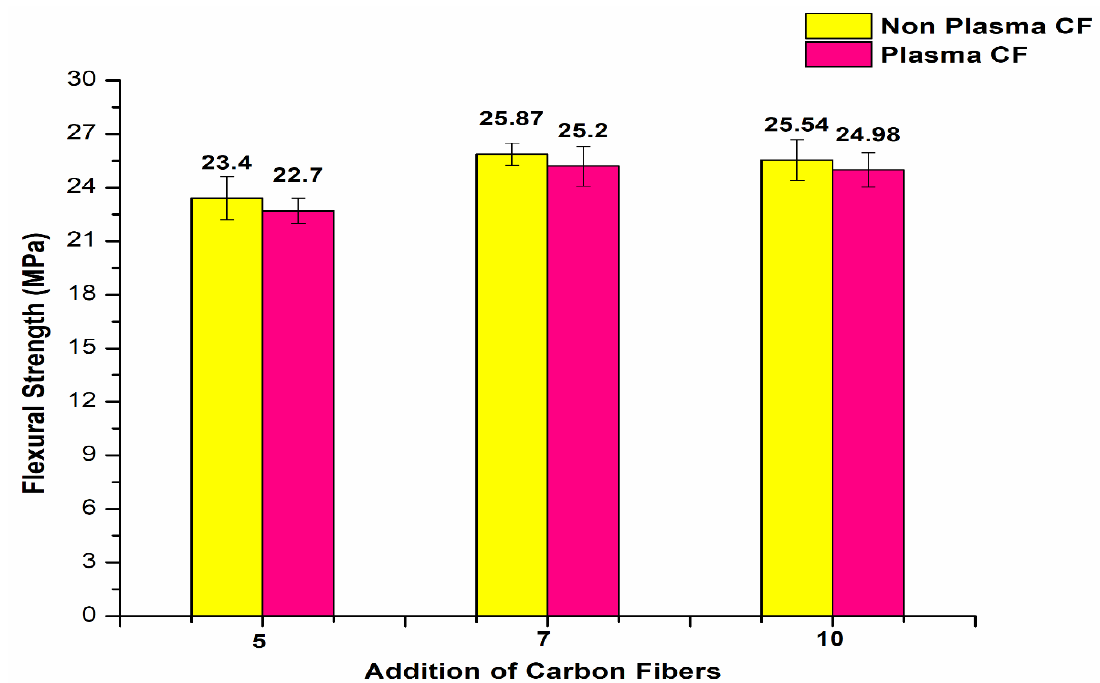
Figure 12. Flexural strength of CF/plasma PE composites.